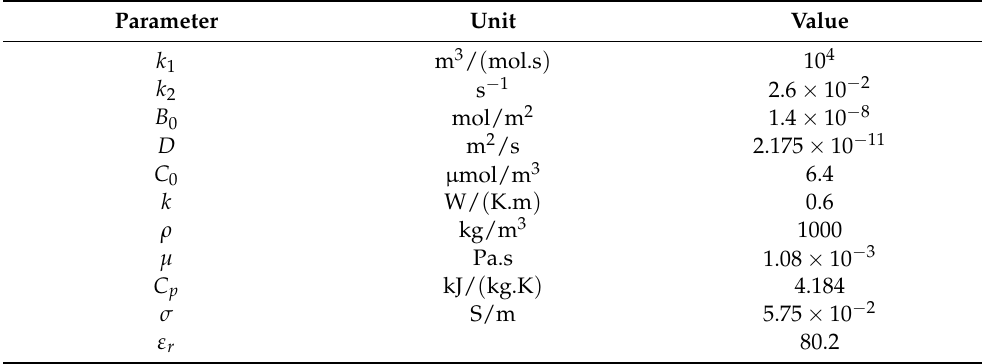
Table 1. Numerical values of the parameters used in the current simulations [21,39,40].